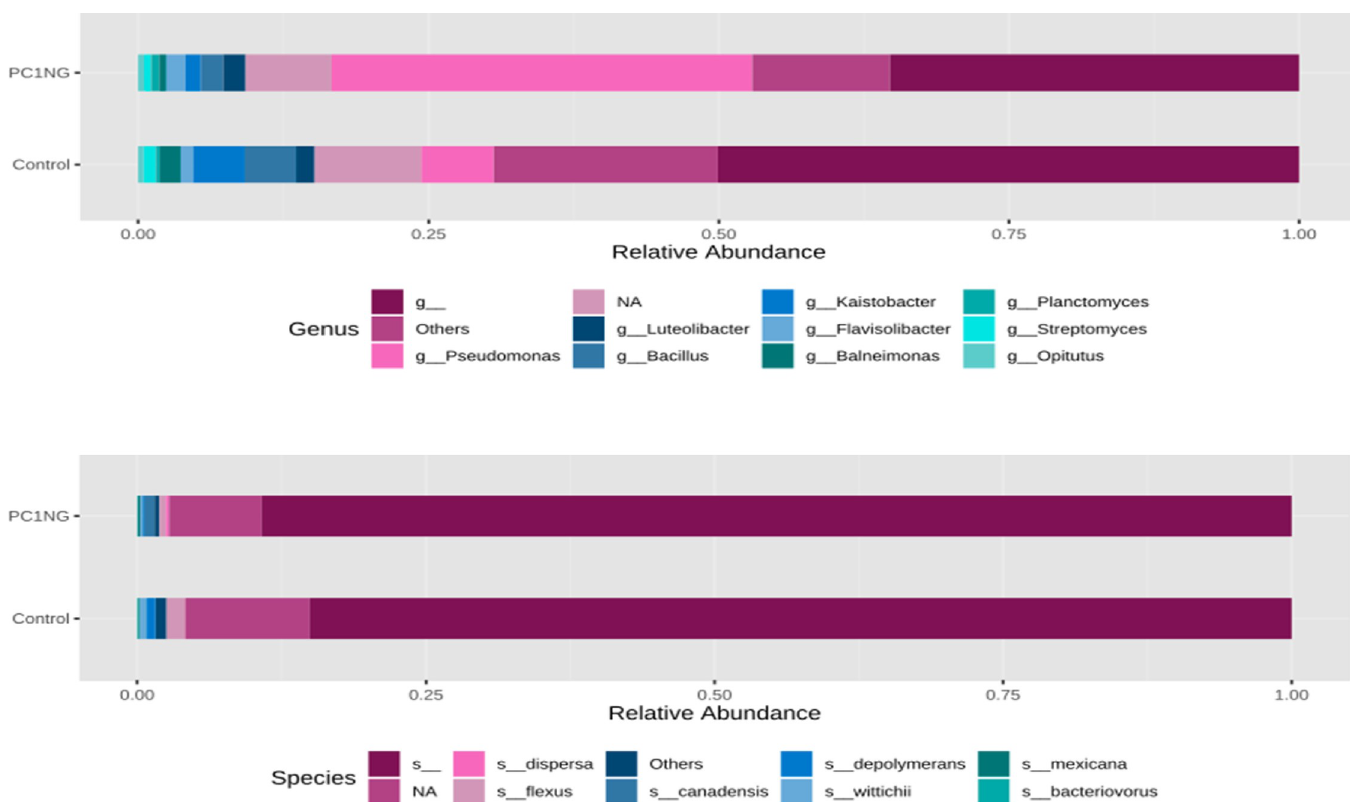
Fig 4. Stacked bar plots representing genus and species distribution in control and treated soil